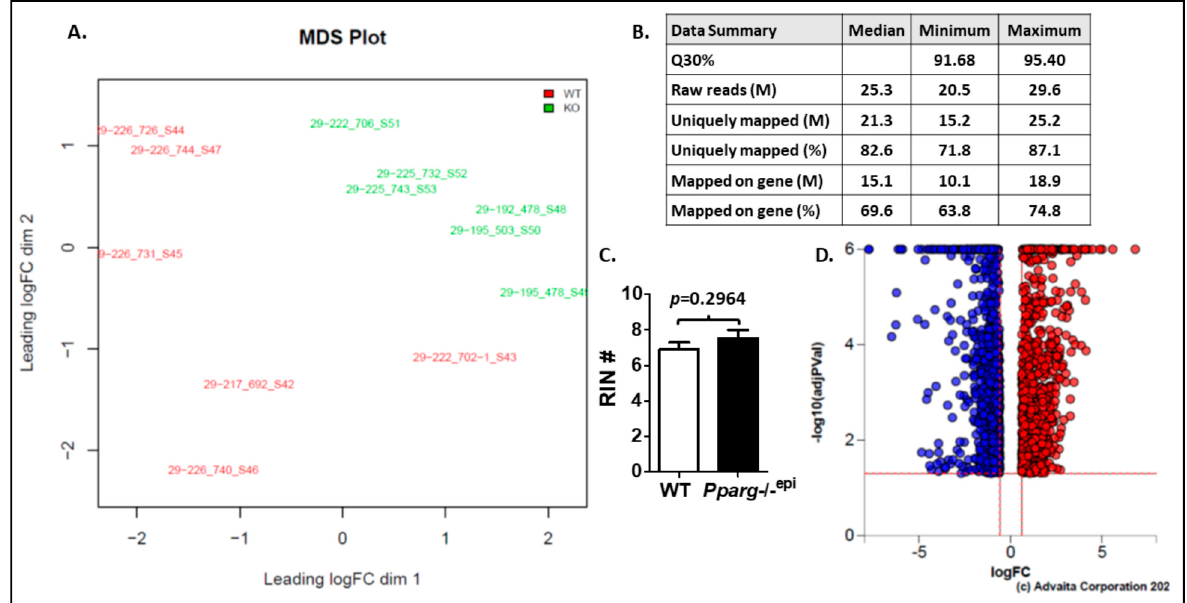
Figure 1. Multi-dimensional scaling (MDS) and quality control (QC) data summary from RNA sequencing data and changes in the transcriptome seen in C57. Pparg -/- epi mice. ( A ) Multi-dimensional scaling plot provides a visual presentation of the similarities/distances among the experimental samples. Distances on the plot correspond to the leading fold-change between each pair of samples. The leading fold change is calculated as the average (root-mean-square) of the largest absolute log-fold changes between each pair of samples. Ideally, samples would cluster well within the main condition/treatment of interest. ( B ) No significant difference is seen in starting RNA quality. RNA sequencing data and QC summary. ( C ) The mean and SEM for the RNA integrity number (RIN) for the WT and C57. Pparg -/- epi ( Pparg -/- epi ) samples are shown. Range = 5.9 to 8.6 and 5.7 to 8.6 for WT and Pparg -/- epi mice, respectively. Two-tailed t -test. ( D ) Volcano plot of differentially expressed genes (Advaita Corp, Ann Arbor, MI). All significant differentially expressed genes are represented in terms of their measured expression change ( x -axis; log2(FC) and the significance of the change ( y -axis). The significance is represented in terms of the negative log (base 10) of the FDR, so that more significant genes are plotted higher on the y -axis. The dotted lines represent the thresholds used to select the DE genes: │ log2 fold-change │ ≥ 0.6 and < 0.05 false discovery rate (FDR). The up-regulated genes are shown in red, while the down-regulated genes are blue.